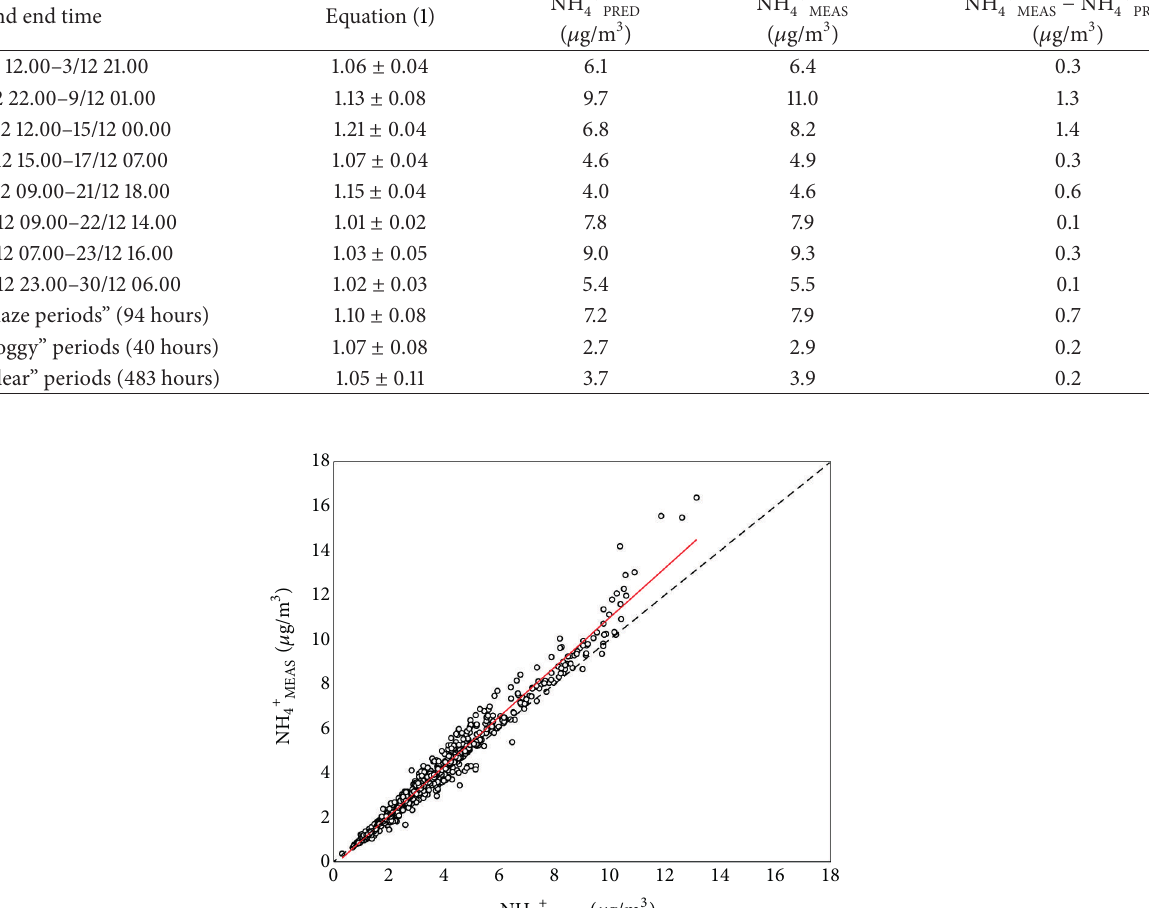
, [NH 4+ ] , and the PRED MEAS